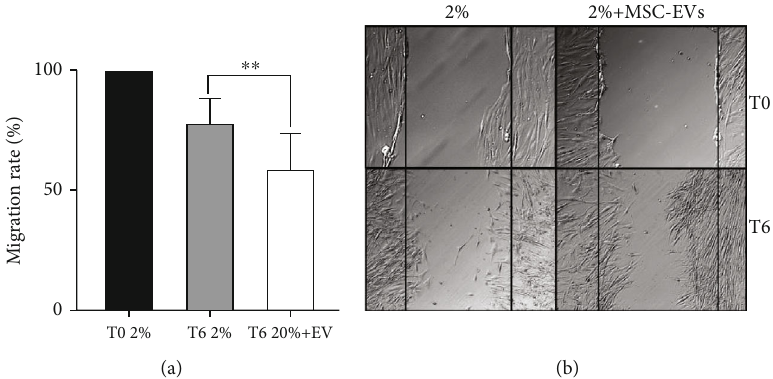
Figure 5: Wound healing assay of HCECs in damage conditions treated with MSC-EVs. (a) Wound healing assays were performed to evaluate cell motility of the HCECs in damage conditions (2% FBS); the migration rate was measured by the length of the scratch at di ff erent timings (T0 and T6), in absence (T6 2%) or in presence of 20 × 10 3 MSC-EV/cell (T6 2 % + EV ). Data are represented as mean ± SD of nine independent experiments normalized to T0 2%. One-way ANOVA analysis with Tukey ’ s multicomparison test was performed among 2% FBS and 2 % + EVs ( ∗∗ p < 0 : 001 ). (b) Representative pictures of HCECs in damage conditions (2% FBS) cultured in the presence or absence of 20 × 10 3 MSC-EV/cell ( 2 % + EV ). Pictures were taken at time 0 (T0) and after 6 hours from the scratch